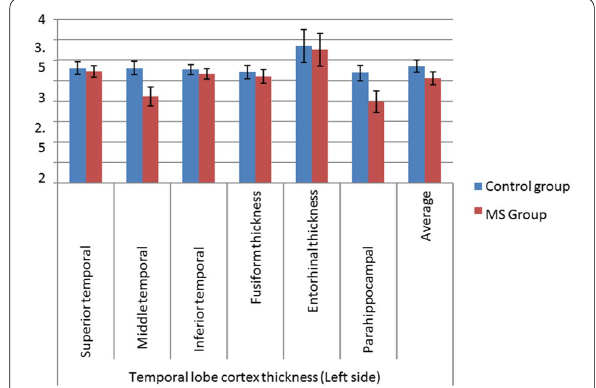
Fig. 3 Comparison between MS and controls according to temporal lobe cortex thickness (left side)